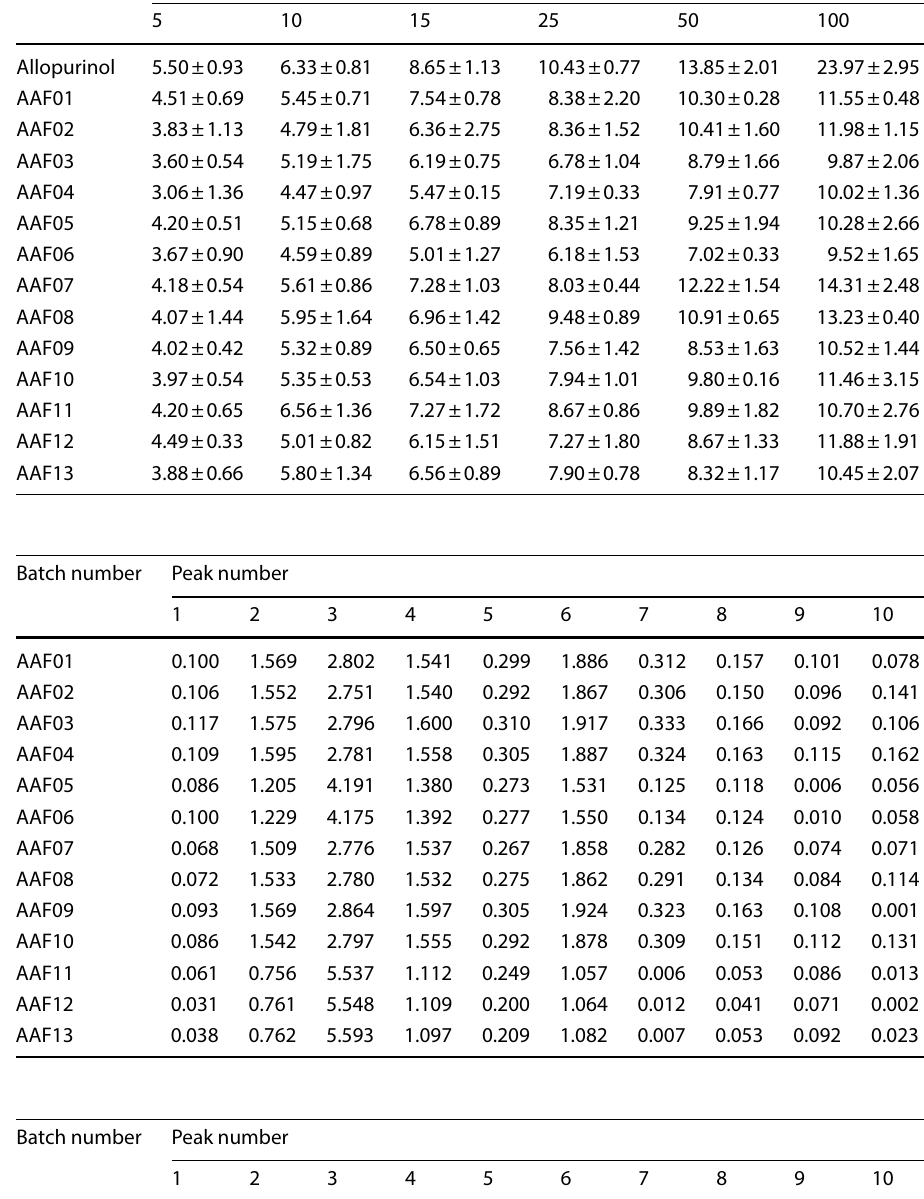
Table 1 Rates of inhibition of xanthine oxidase by samples with different concentrations (mean ± standard deviation) (n = 5)